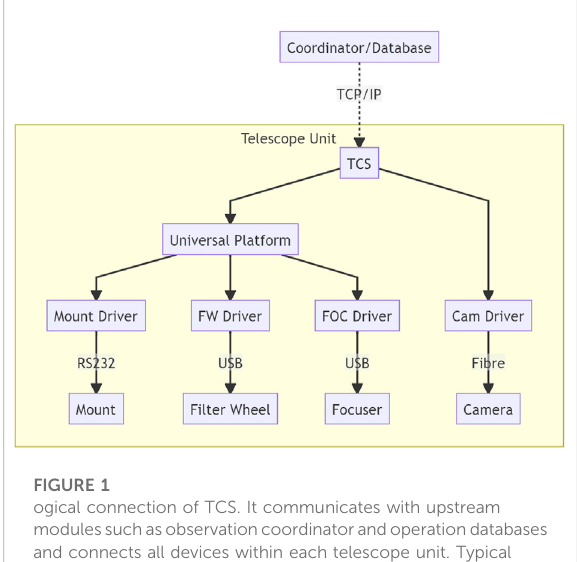
ogical connection of TCS. It communicates with upstream modulessuchasobservationcoordinatorandoperationdatabases and connects all devices within each telescope unit. Typical devices including mount, fi lter wheel, and focuser are connected via a universal platform, which can supply a standard API, but also some devices such as camera can be connected directly due to the performance